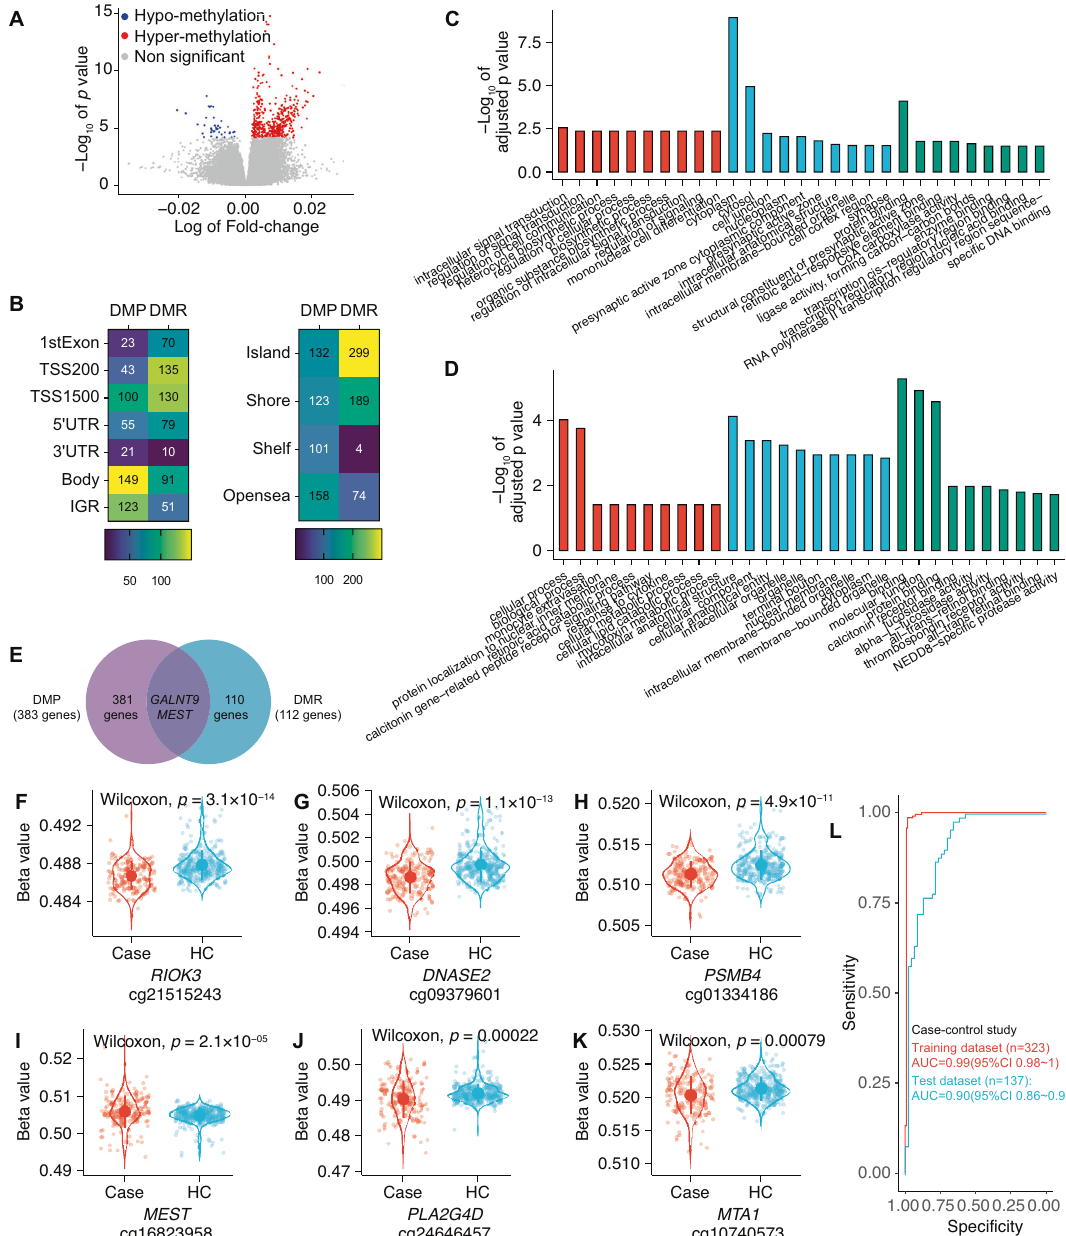
Fig. 1 Differential methylation analyses in the case-control study. A Volcano plot for differentially methylated positions (DMPs). Gray points represented the nonsigni fi cant DMP; red and blue points represented the signi fi cant DMPs with hyper or hypo-methylation (case vs control), respectively. B Heatmap plots, the left heatmap described the regions of CpG sites: the detected DMPs were mainly enriched in regions as body (149 CpG sites [28.99%]), IGR (intergenic region, 123 CpG sites [23.93%]), and TSS1500 (100 CpG sites [19.46%]), and were less enriched in TSS200 (43 CpG sites [8.37%]), 5 ’ UTR (55 CpG sites [10.7%]), 3 ′ UTR (21 CpG sites [4.09%]) and 1st exon (23 CpG sites [4.47%]); The CpG sites from DMRs were mainly from the regions as TSS1500 (130 CpG sites [22.97%]), TSS200 (135 CpG sites [23.85%]), 1st exon (70 CpG sites [12.37%]), 5 ′ UTR (79 CpG sites [13.96%]), and were less from the regions like 3 ′ UTR (10 CpG sites [1.77%]) and IGR (51 CpG sites [9.01%]). The right heatmap described the location of CpG sites: the detected DMPs were located in opensea (158 CpG sites [30.74%]), island (132 CpG sites [25.69%]), shore (123 CpG sites [23.93%]), and shelf (101 CpG sites [19.65%]). CpG sites of DMRs were in island (299 CpG sites [52.83%]), shore (123 CpG sites [23.93%]), and opensea (74 CpG sites [13.07%]) and were less located in shelf (4 CpG sites [0.71%]). C Bar plot for the top 10 terms for biological process, molecular function, and cellular component from gene ontology analysis of DMP-annotated genes. D Bar plot for the top 10 terms for biological process, molecular function, and cellular component from gene ontology analysis of DMR-annotated genes . E Venn diagram for the overlap gene between DMP and DMR. The illustrations of important DMPs were shown in ( F – K ), patients with GAD or OCD (case) and healthy controls (HC) are distinguished by different colors. The Y -axis represented the beta value of each CpG probe. Wilcoxon test was used to test the signi fi cance of difference of mean beta value between two groups. L The diagnose model performance in classi fi cation of cases and HC: the model got the AUC of 0.99 (95%CI 0.98 – 1, red line) and 0.90 (95%CI 0.86 – 0.96, blue line) in training dataset ( n = 323) and test dataset ( n = 137),